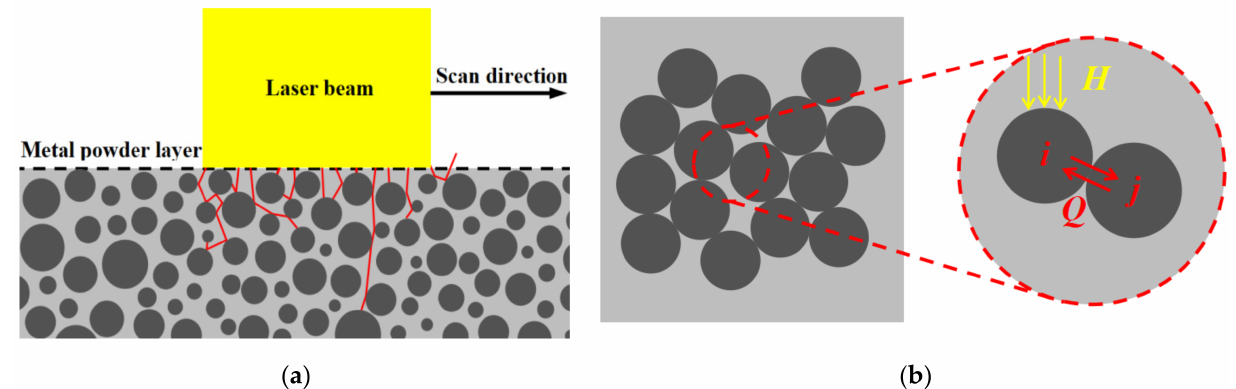
Figure 4. ( a ) Reflection of laser beam and metal powder. ( b ) Heat conduction between